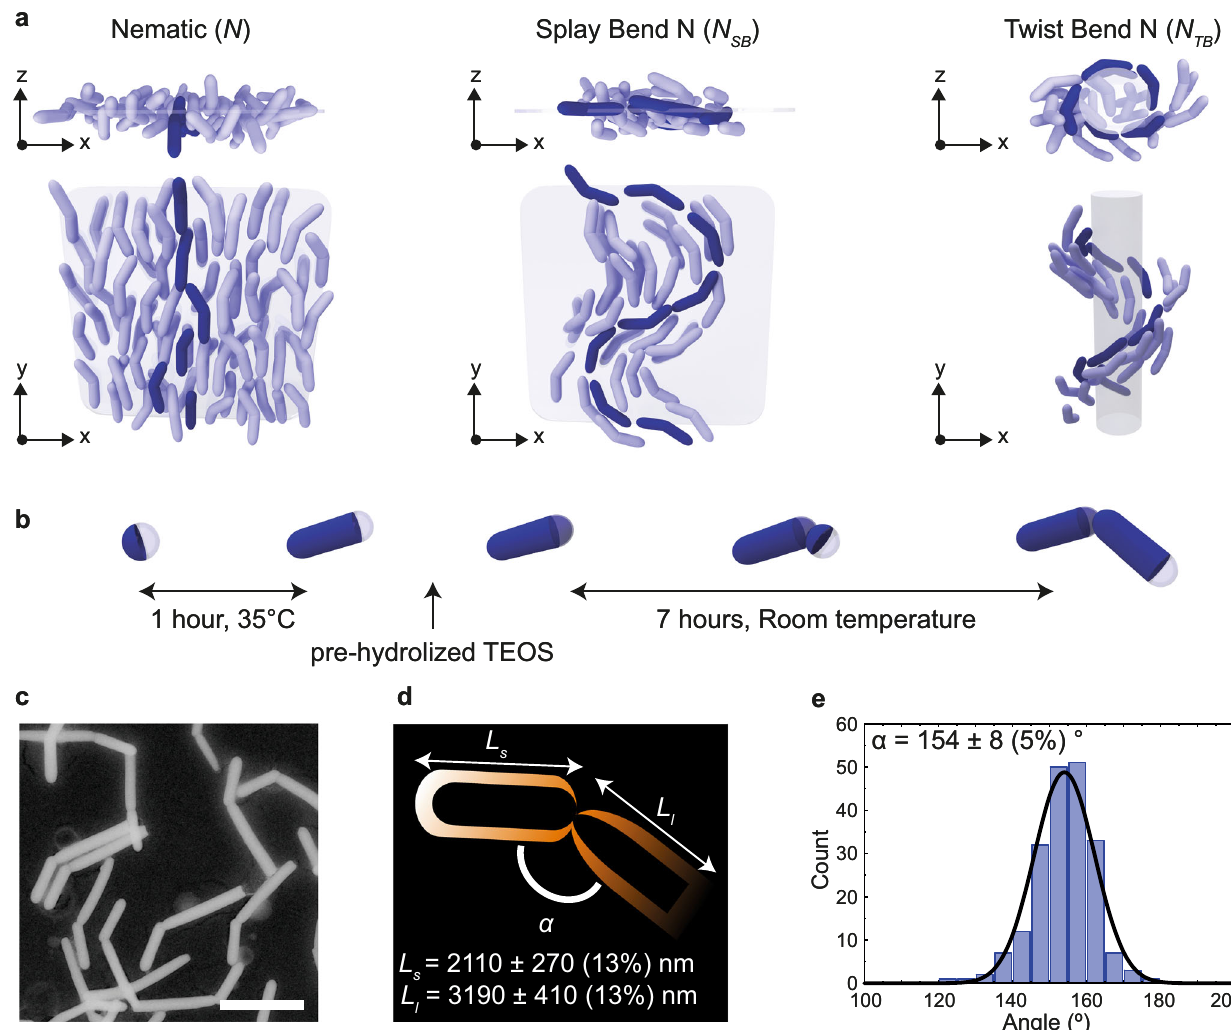
Fig. 1 | Schematics of LC phases and characterization of a system of bent silica rods (BSRs). a Side and top schematic views of a uniaxial N , splay-bend N SB , and twist-bend N TB nematic liquid crystal phase of bent-core rod-like particles. The darker particles highlight the change in orientation of the nematic director along thesample,whichextendstoa3Dmodulationinthe N SB and N TB phases.The xy and xz planes are indicated as will be de fi ned further for confocal microscopy.